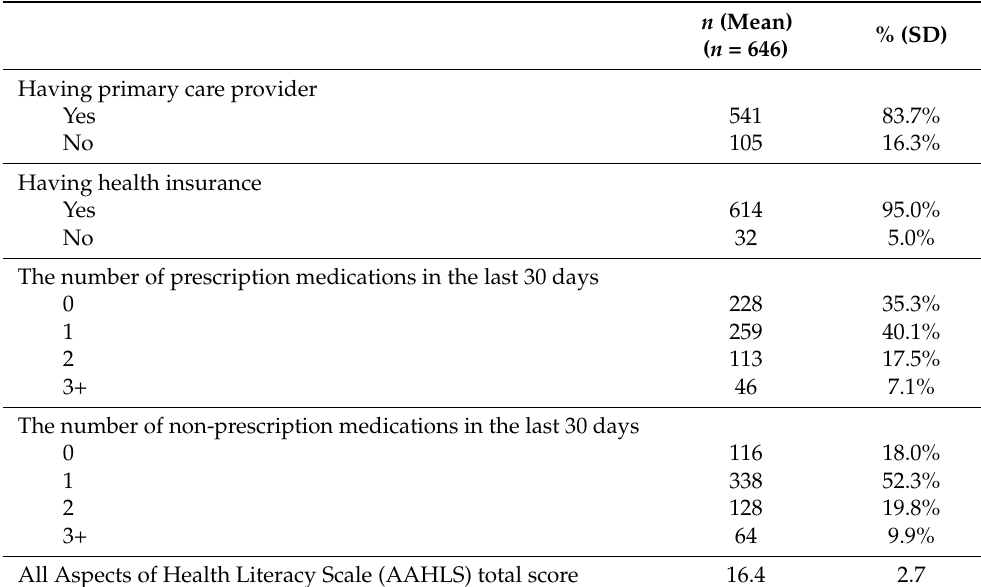
Table 3. Participant health-related characteristics.